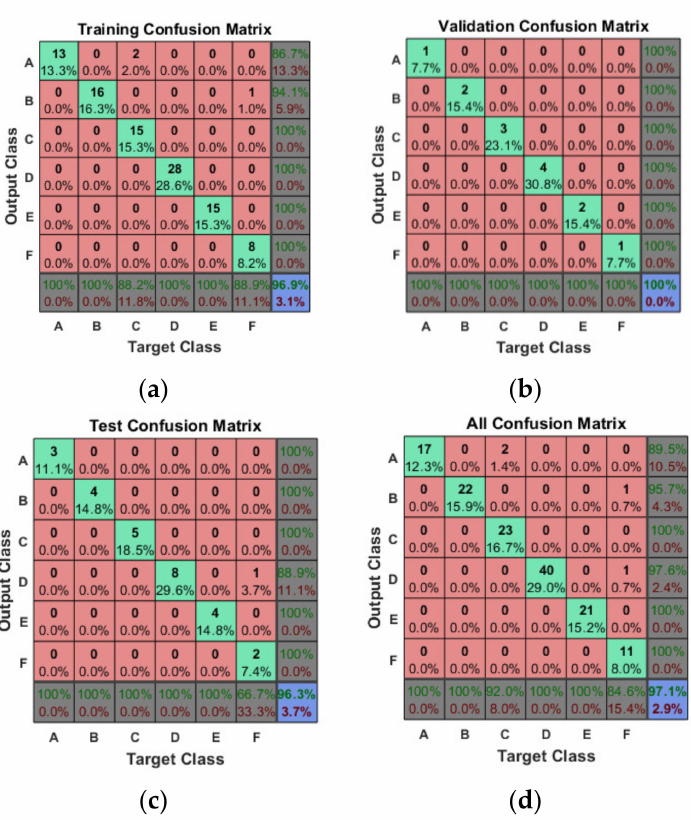
Figure 19. The confusion matrices of ANN trained with SE feature set: ( a ) training confusion matrix, ( b ) validation confusion matrix, ( c ) testing confusion matrix, and ( d ) overall confusion matrix.